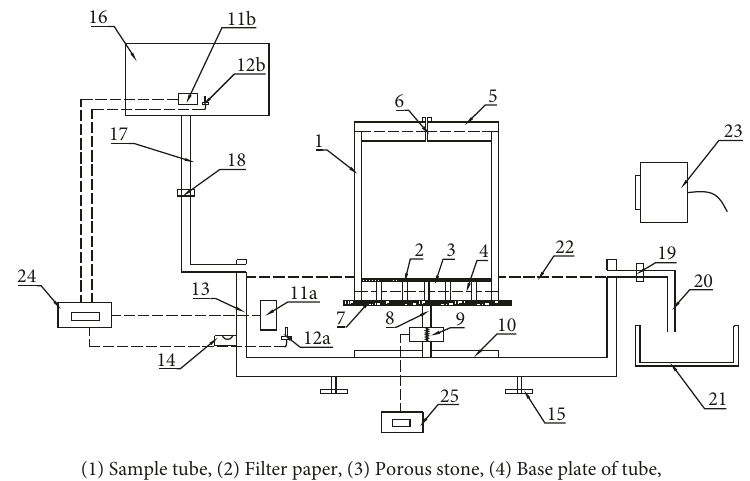
(1) Sample tube, (2) Filter paper, (3) Porous stone, (4) Base plate of tube, (5) Cap of tube, (6) Pressure relief valve, (7, 8, 9, 10, 25) Weighing system,